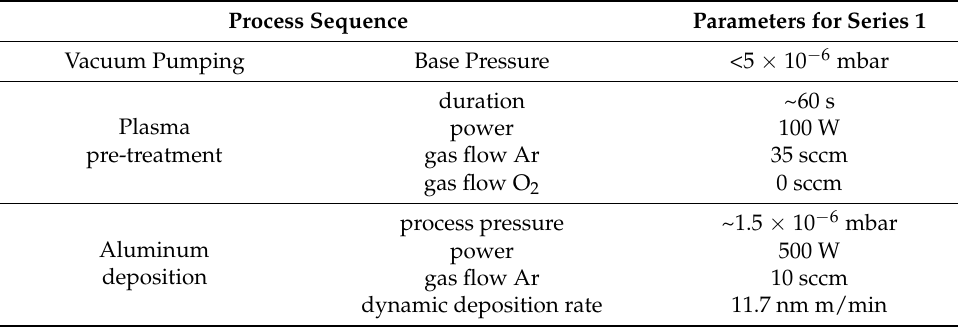
Table 2. Process sequence and parameters for aluminum deposition series 1.